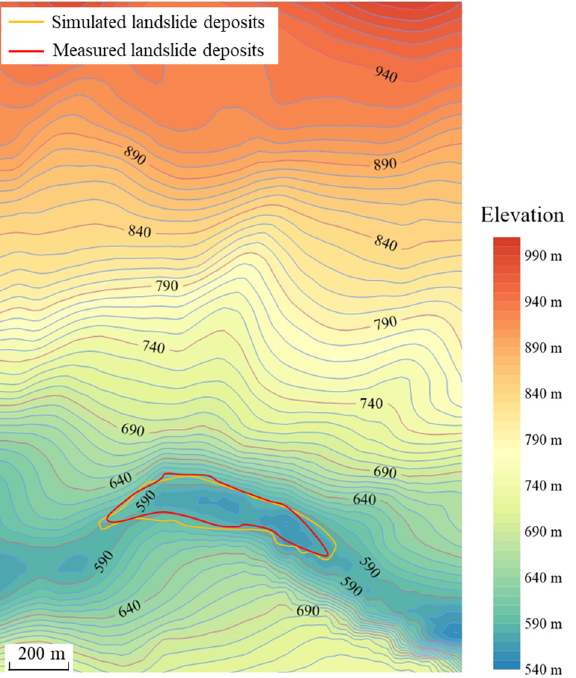
Figure 17. Comparison of the simulated and measured deposition zone of the Shaziba landslide.